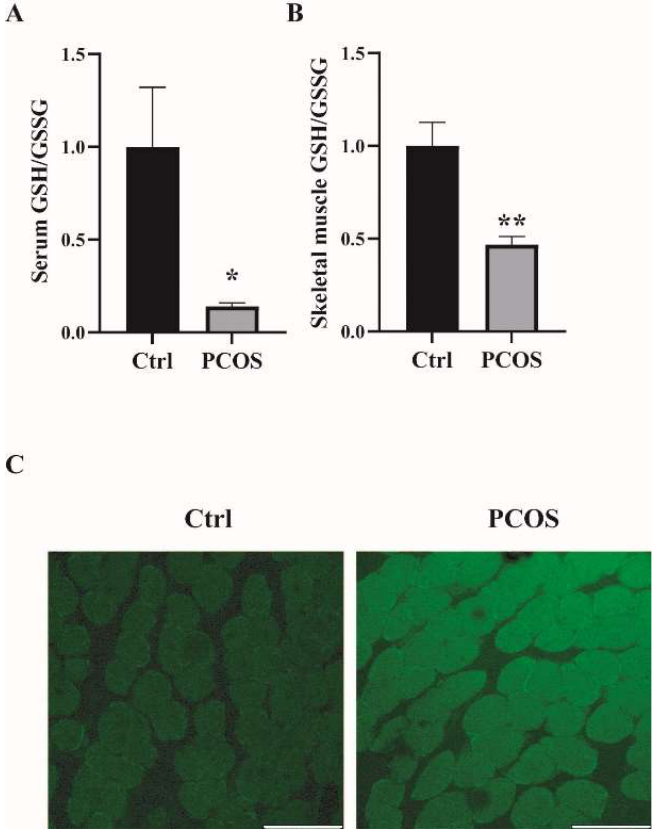
Figure 1. Increased oxidative stress in the whole-body and skeletal muscles of mice with DHEA- induced PCOS. ( A ) Metabolomics analysis of GSH/GSSG in serums of PCOS and control mice. ( B ) Metabolomics analysis of GSH/GSSG in the skeletal muscles of PCOS and control mice. ( C ) Representative photomicrographs of ROS relative fluorescence units (RFU) in the soleus muscles were measured by staining with DCFH-DA. Scale bar = 100 µ m. Asterisks indicate significant differences between control and PCOS mice. The data are presented as means ± SEM. *, p < 0.05, **, p < 0.01, n = 6,7 per group.